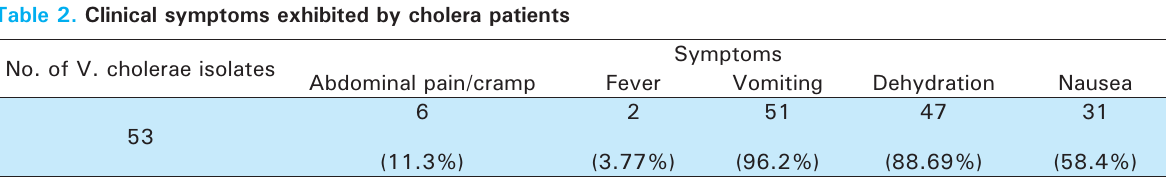
Table 3. Physical characteristics of stool exhibited by cholera patients Stool passage frequency Per